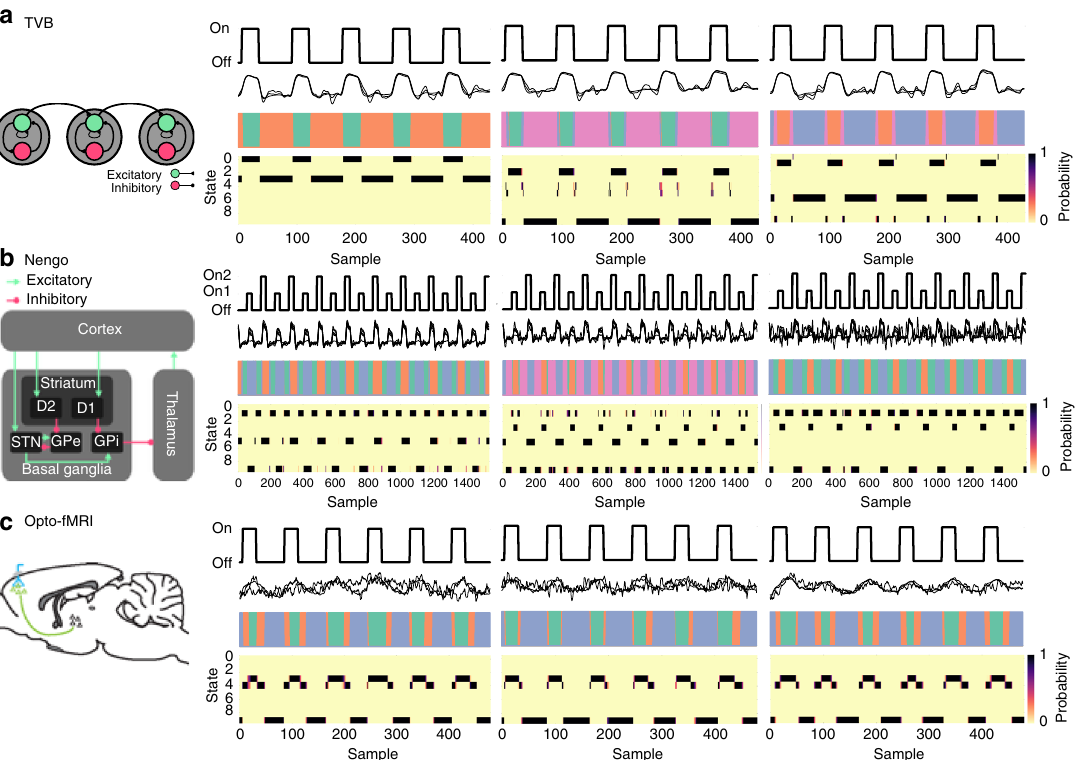
Fig. 2 Illustration of dynamic brain states that were automatically estimated using BSDS. In both simulated and experimental opto-fMRI data, BSDS accurately and reliably identi fi ed distinct brain states across time. a Data simulated using neurophysiological realistic models implemented in The Virtual Brain (TVB); b Data simulated using a cortico-thalamic-basal ganglia model implemented in Neural Engineering Object (Nengo). In each simulation, three exemplar data (subjects) and results are presented in the three sub-panels from left to right. In each sub-panel, the top row illustrates task waveform (e.g., stimulation on and off states); the second row shows simulated time series; the third row shows the temporal evolution of each latent state; and the bottom row shows posterior probabilities of each states across time. Note that for a and b BSDS was applied in a subject-wise fashion. c Dynamic brain states determined from experimental opto-fMRI data acquired during in vivo optogenetic stimulation in three rodents. In addition to ON and OFF states, BSDS also identi fi ed a novel transition state associated with switching between the ON and OFF states. Here, BSDS was applied in a group-wise fashion. The rodent brain diagram in the left column is adapted from a previous study